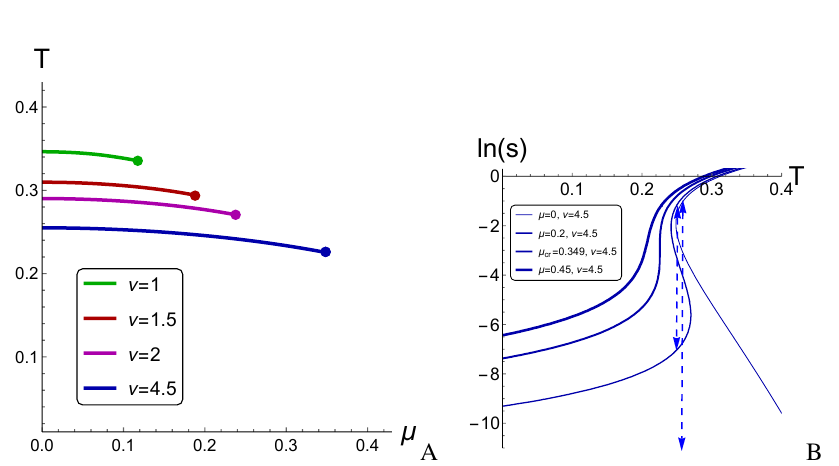
1 and di ff erent ν B) The thermal −